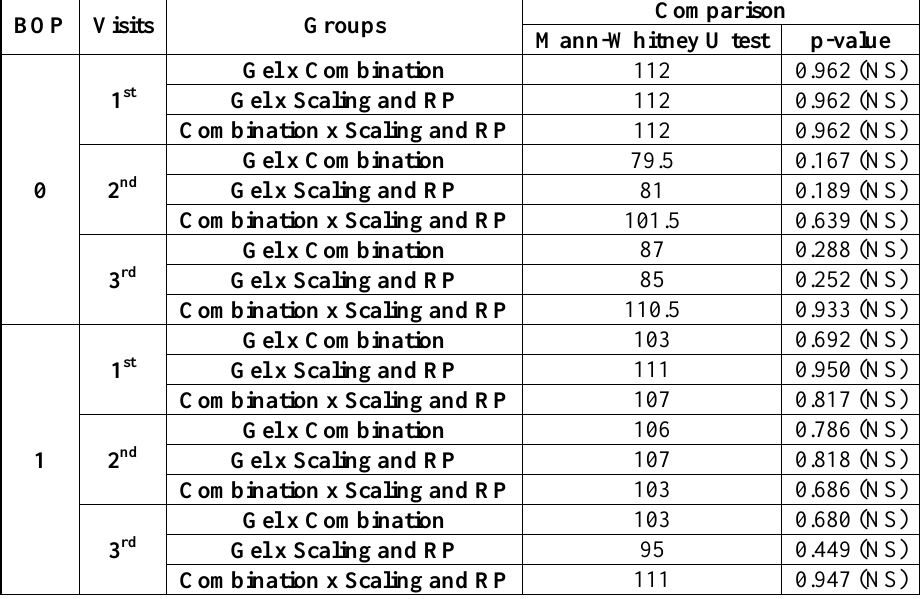
Table 4: Inter-Groups Comparison between Each Two Groups of the Clinical Periodontal Parameter (Bleeding on Probing) Scores by Mann-Whitney U test at Each Visit BOP